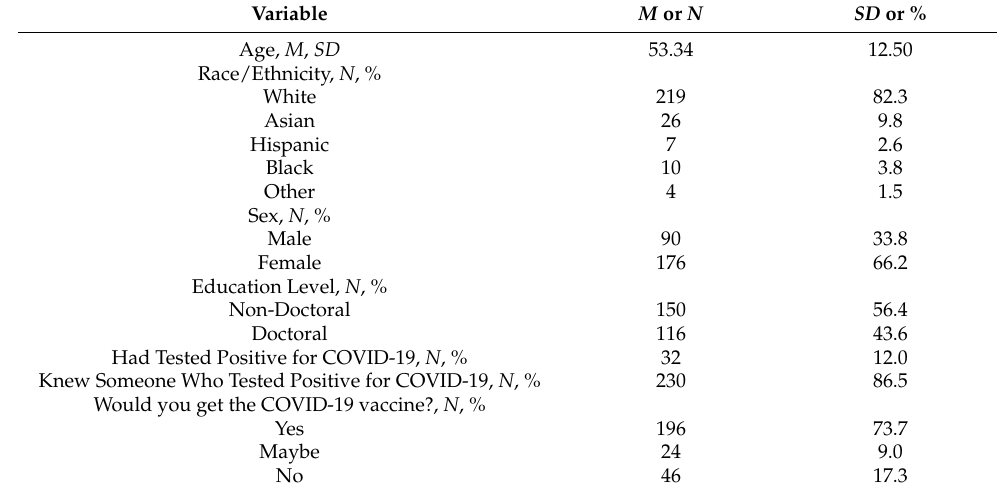
Table 1. Participant ( n = 266) Demographics and COVID-19 Vaccine Hesitancy